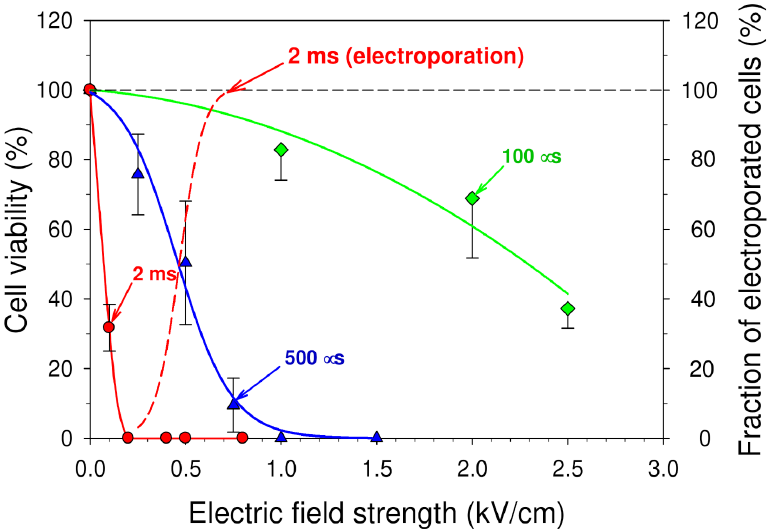
Figure 2. The cytotoxicity of a culture medium pre-treated with a single square-wave electric pulse. The viability of mouse hepatoma MH-22A cells (ordinate) is presented as a function of electric field strength (abscissa). The cells were grown for 9–10 days in the medium pre-treated with a square-wave electric pulse with a duration of 100 µ s, 500 µ s, or 2 ms. The electrodes (both the anode and the cathode) made of stainless steel were used in all experiments. The cell viability was estimated by a colony-forming assay. The dashed line shows the dependence of the fraction of cells, which were electroporated by a single 2 ms duration pulse (data are taken from Figure